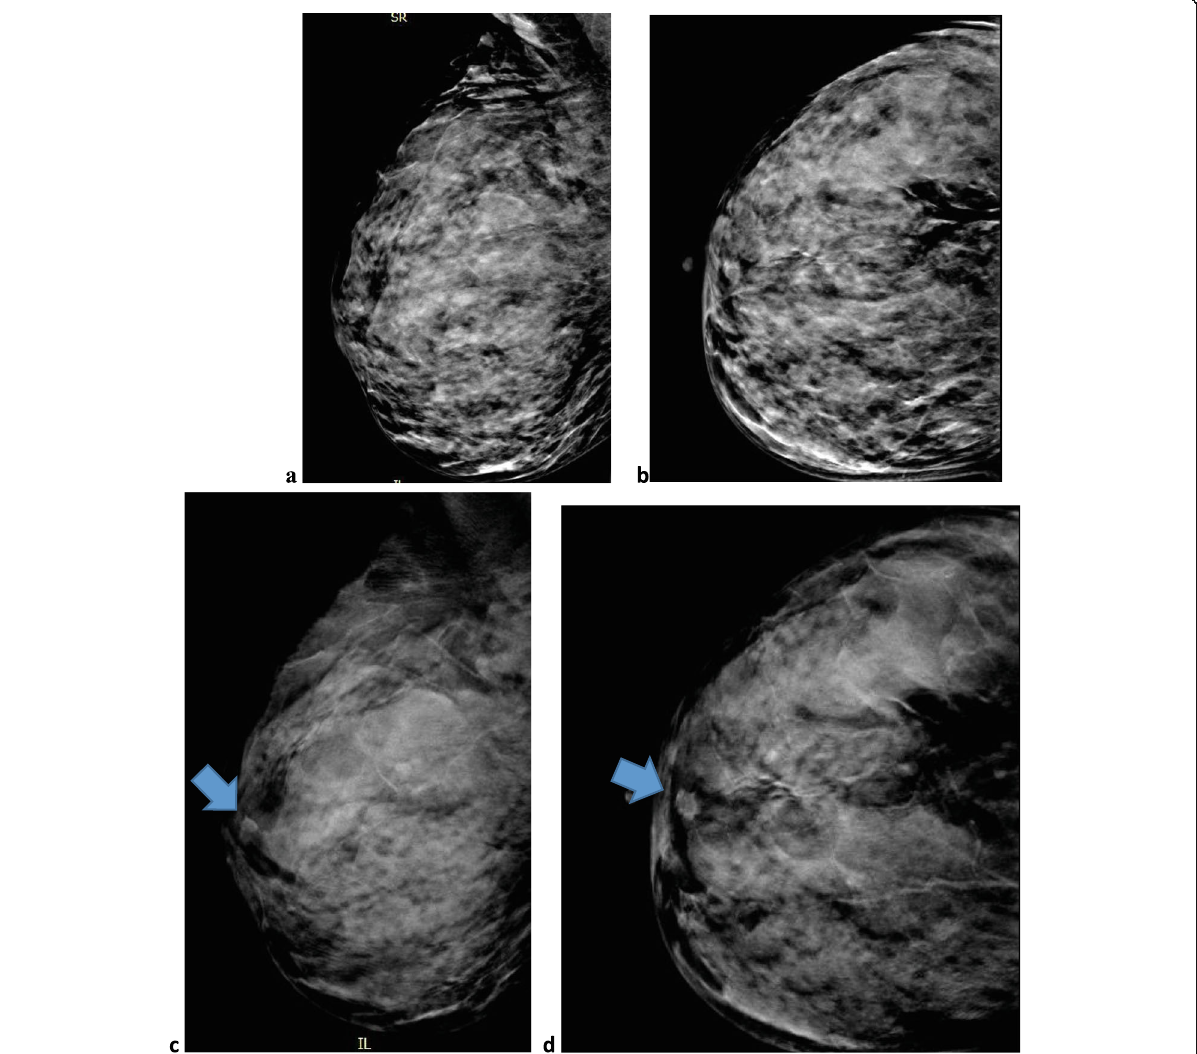
Fig. 6 A 42-year-old patient, presented by right breast mass. a , b FFDM in MLO and CC views of the right breast: the right breast shows extremely dense parenchyma (ACR d ). No spiculated mass or suspicious calcifications are seen (BIRADS I). a , d DBT in MLO and CC views of the right breast show a retro-areolar irregular, ill-defined, and spiculated mass (BIRADS IVc). TRU CUT biopsy revealed right breast